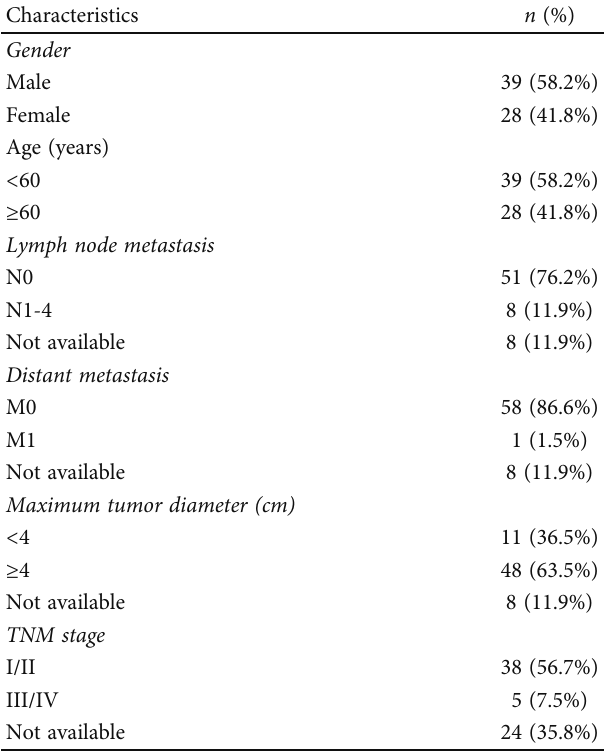
Table 1: Clinicopathologic characteristics of patients with malignant melanoma from the MME1004i tissue microarray